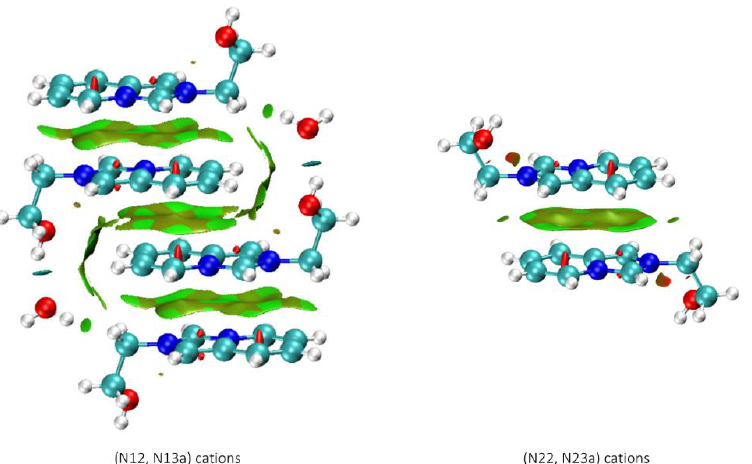
Figure 7. Reduced density gradient surfaces (isovalue of 0.5) showing vdW interactions (green area) between [L1] + cations and strong hydrogen bonds with participation of water molecules in the crystal structure of 1 (the major component of the disordered (N22, N23A) cation is shown). The colour scheme corresponds to the sign(λ 2 ) ρ ( r ) function with the second largest eigenvalue of the Hessian of electron density, λ 2 , at respective points: negative (blue, strong attraction), nearly zero (green, vdW interaction), positive (red, strong repulsion).